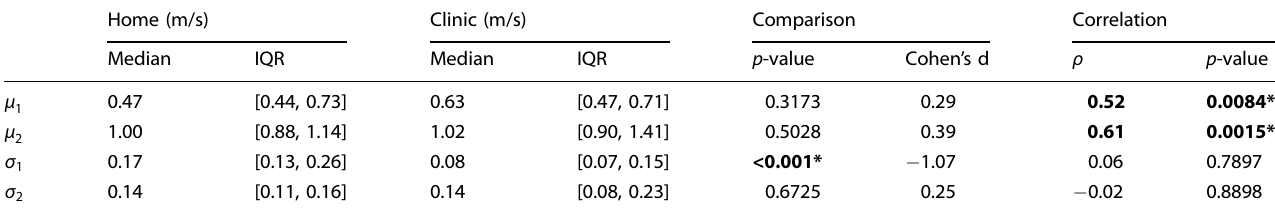
Table 1. Comparison of the preferred gait speeds along with their corresponding deviations between clinic and home, the signi fi cance level (* in bold) was set to 0.05, two-sided Wilcoxon rank sum test, Cohen ’ s d was calculated for effect size. Home (m/s) Clinic (m/s) Comparison